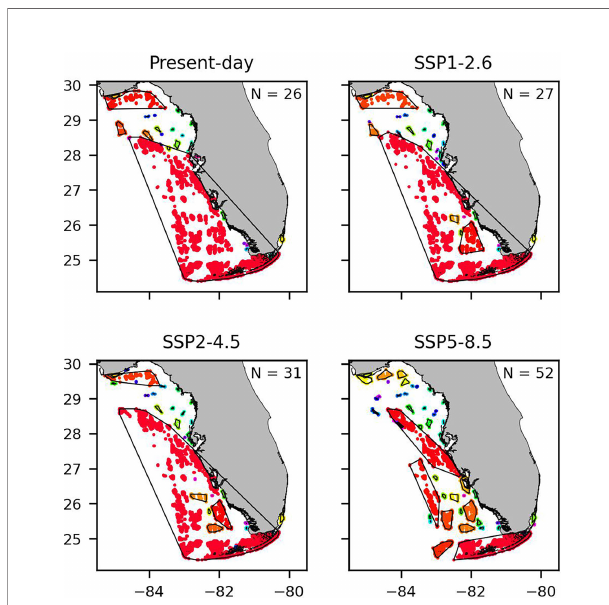
FIGURE 6 | Map of the communities obtained with the SCC method for each climate change scenario. Each community is coloured in a different colour and is circled by a black